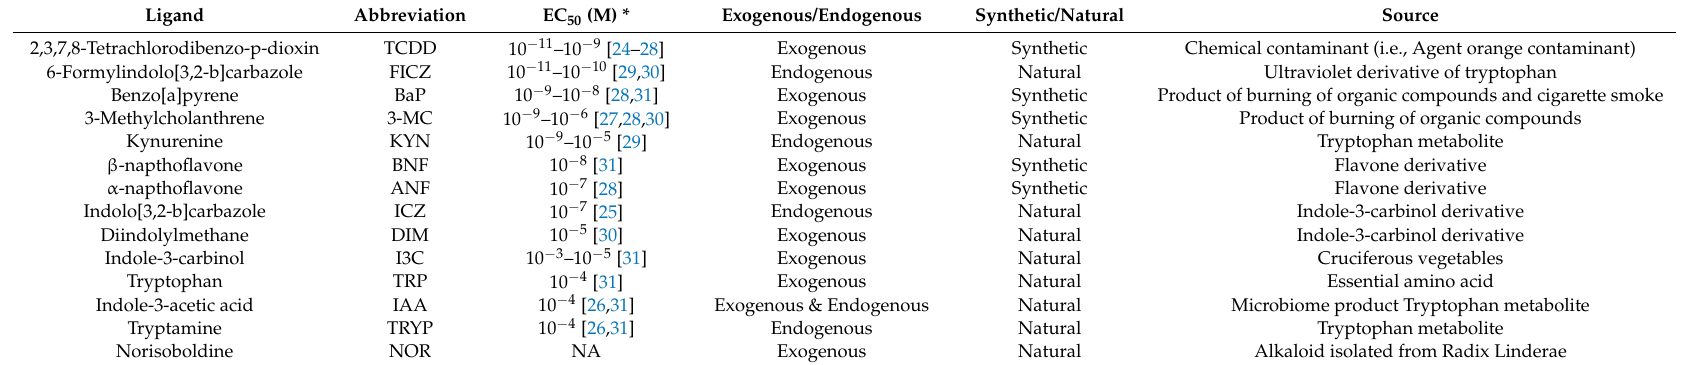
Table 1. AHR ligands. A list of common AHR ligands, their abbreviations, their EC 50 values, whether they are exogenous or endogenous, whether they are synthetic products or natural products, and their source. The table is sorted by EC 50